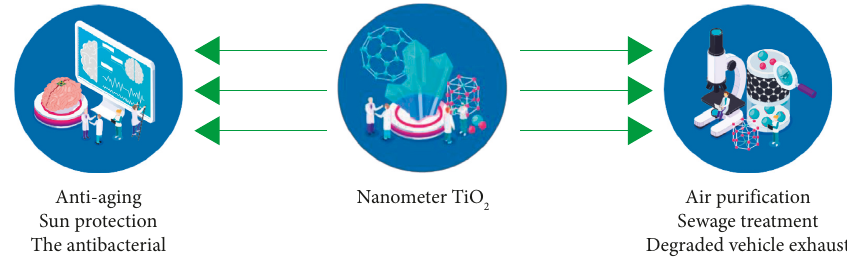
Figure 1: Preparation and photocatalytic performance of nano